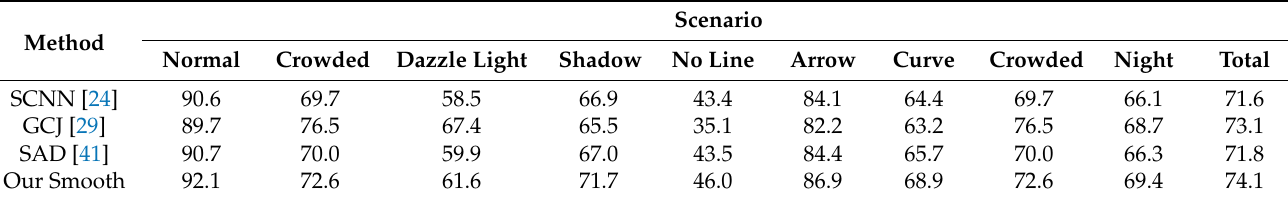
Table 2. Model performance